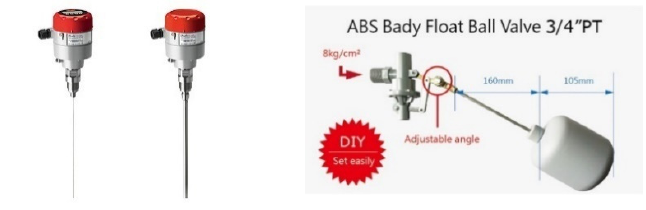
Figure 9. The traditional floating ball water level switch.